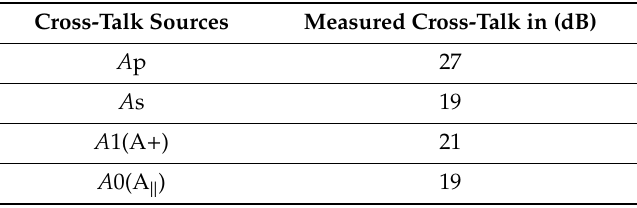
Table 1. Measured cross-talk of FLC binary optical